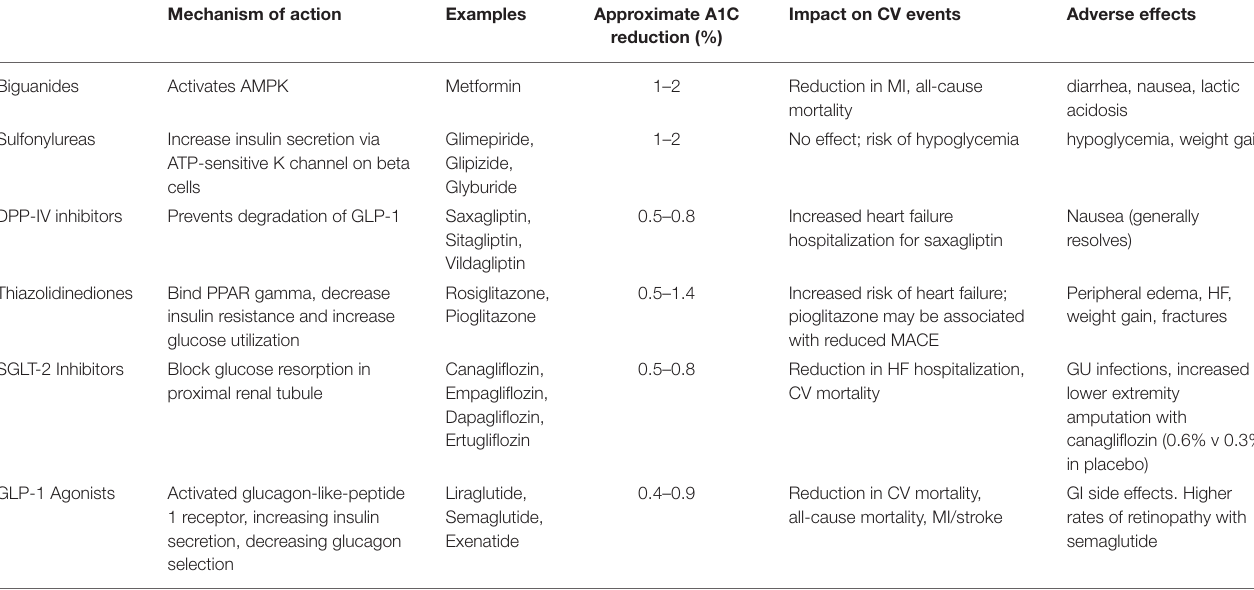
TABLE 1 | Common oral hypoglycemic medications.